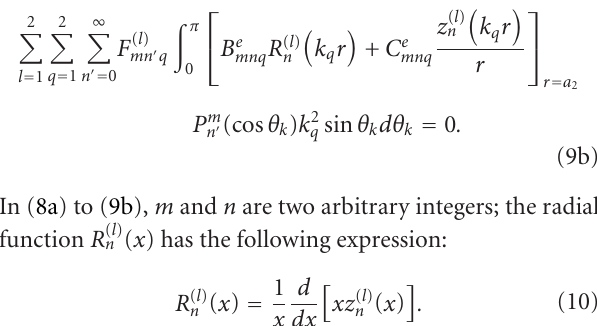
are characterized by (cid:2) 1 = 7 (cid:2) 0 , (cid:2) 2 = i (cid:2) 0 , and (cid:2) 3 = 5 (cid:2) 0 ; the electric size of the plasma anisotropic spherical shell is chosen as k 0 a 1 = 2 . 2 π and k 0 a 2 = 2 π . Figure 4 depicts a thick plasma anisotropic medium coated conducting sphere, and